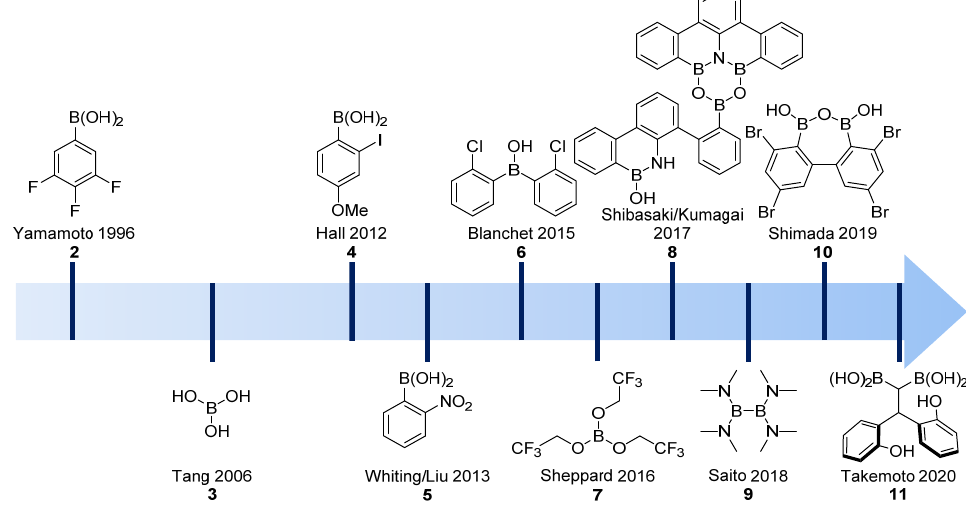
Figure 1. Evolution of boron ‐ derived catalysts used in direct amidation reactions.